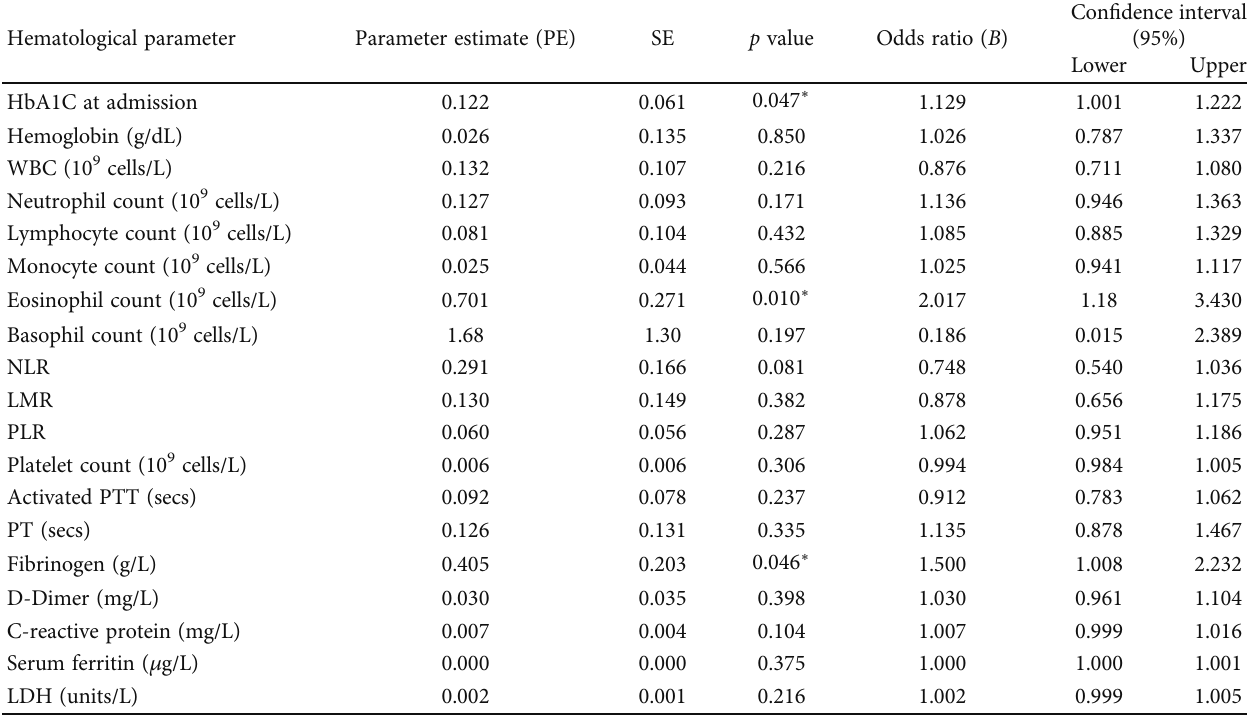
Table 4: Logistic regression analysis to know the impact of lab parameters on COVID-19 severity.